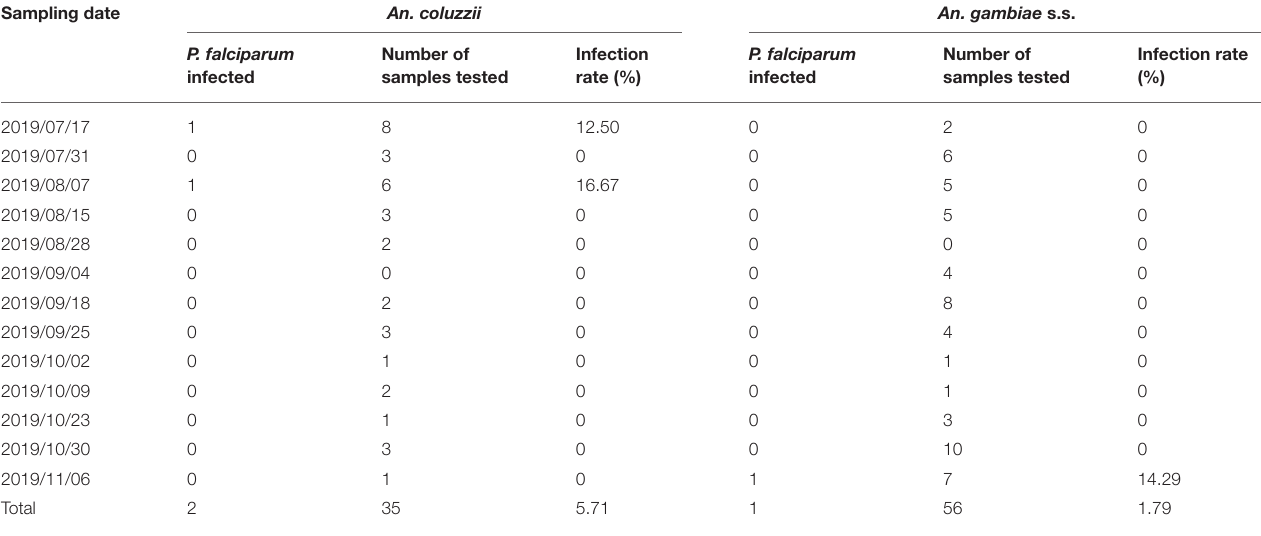
TABLE 5 | Plasmodium falciparum infection of An. gambiae complex individuals collected in Lakka from June to December